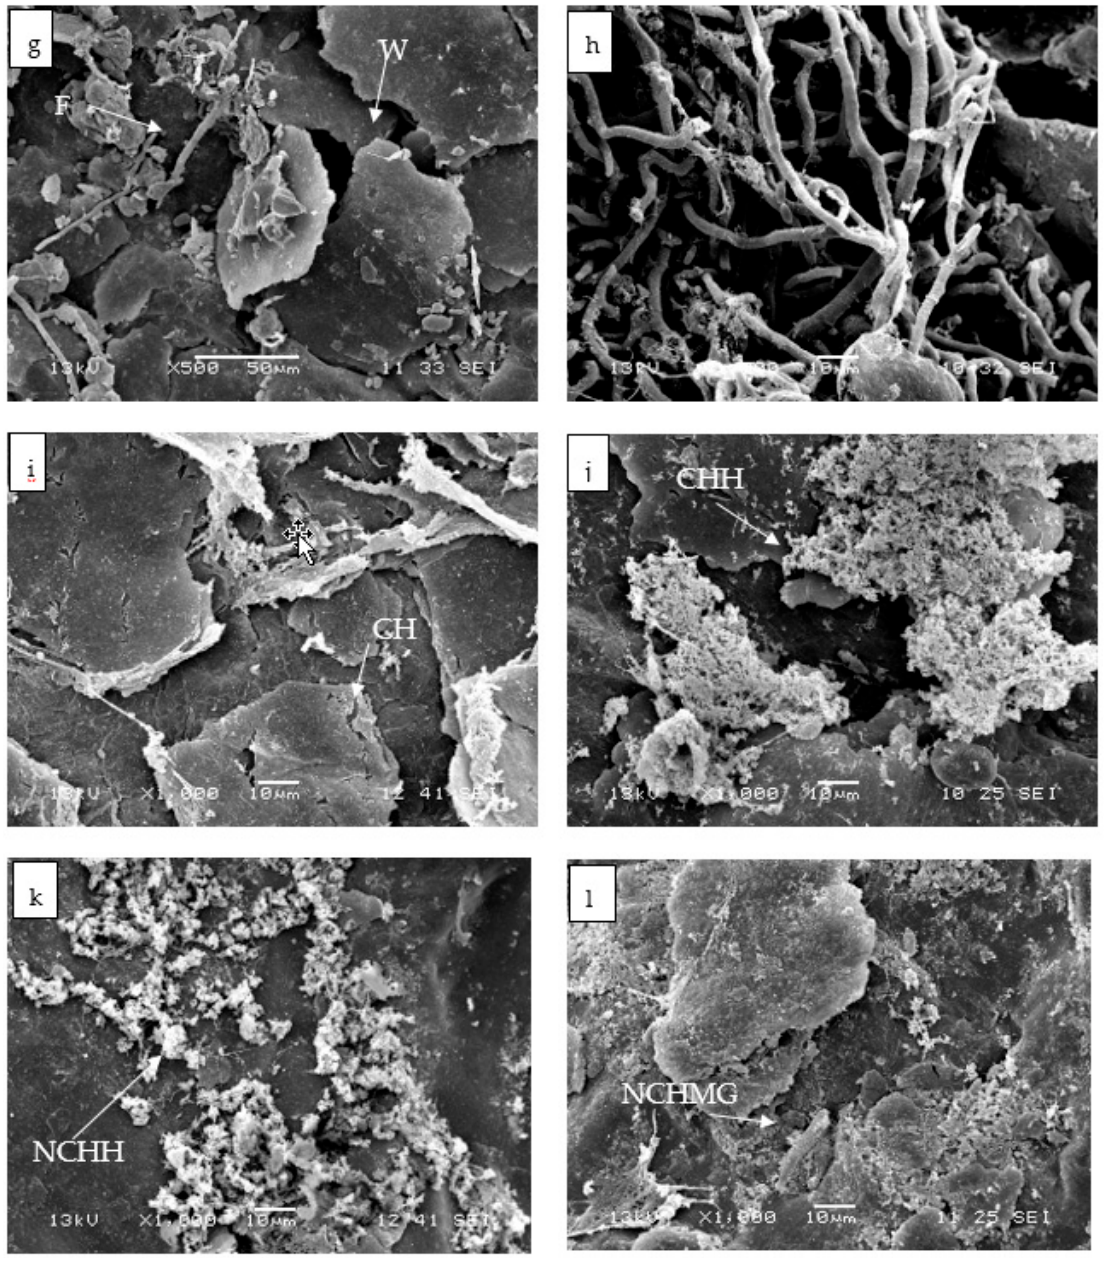
Figure 7. SE micrographs of coatings on pitayas at the initial time: Control ( a ), Alternaria inoculated ( b ), CH ( c ), CHH ( d ), NCHH ( e ), and NCHMG ( f ). At 15 d of storage: Control ( g ), Alternaria inoculated ( h ), CH ( i ), CHH ( j ), NCHH ( k ), and NCHMG ( l ). (See Table 2 for treatment identification). W is a natural wax, and F is fungi (three preparations per treatment with 10 observations in SEM).